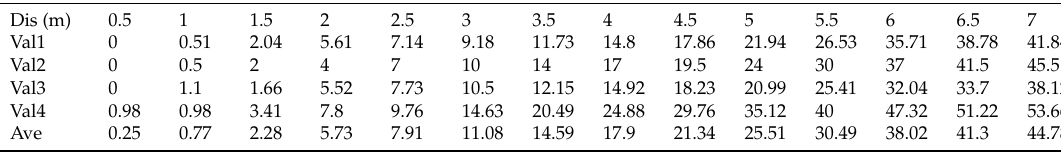
Table 2. Recall while using a single size of 3D-window.